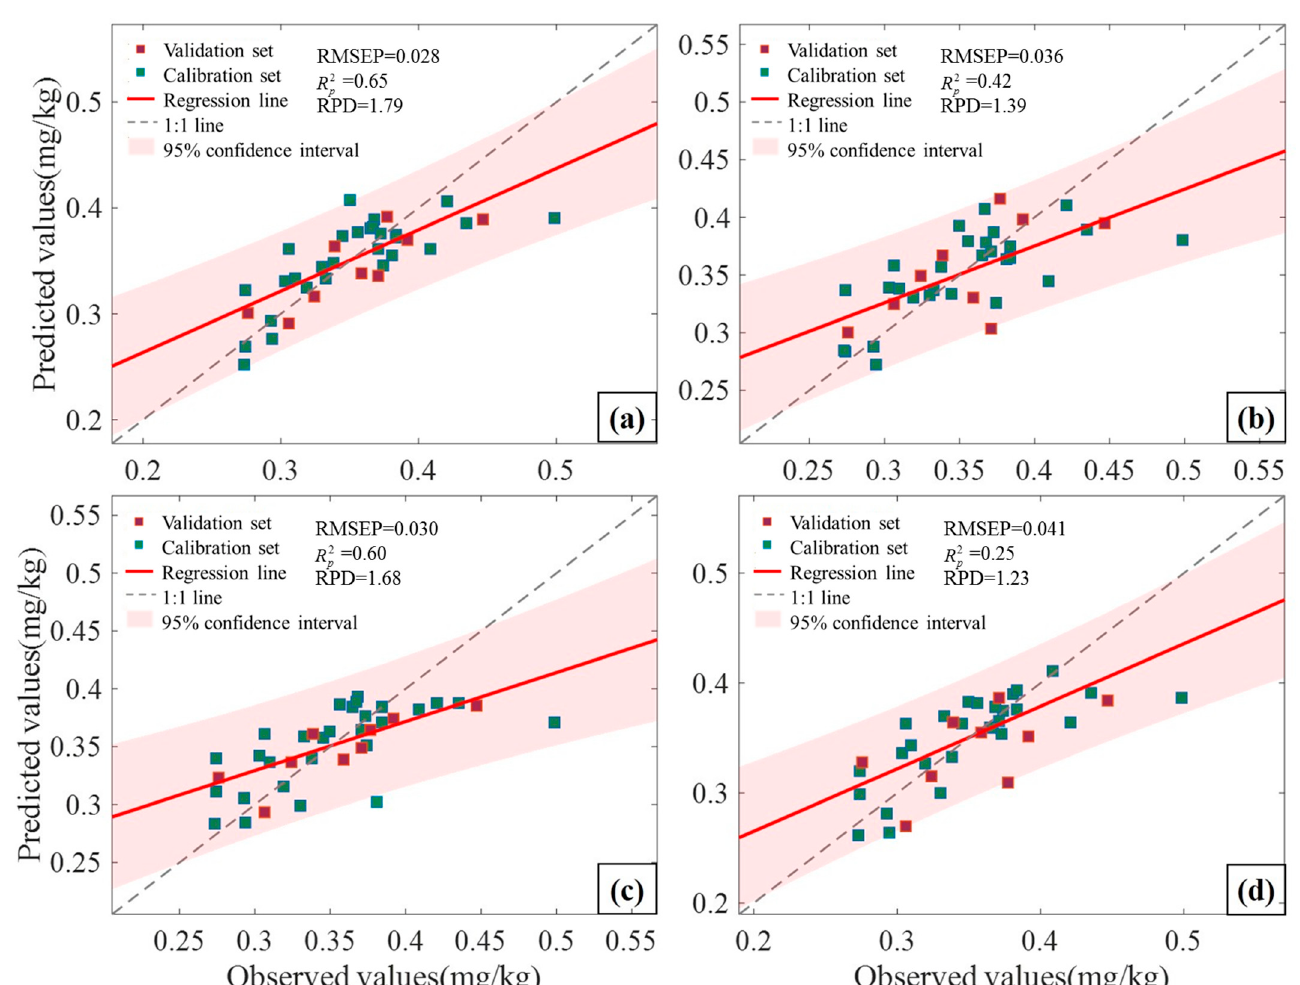
Figure 8. Scatter plots of the observed against predicted Cd concentration of Baoding sample set: ( a ) PLS NSS-VIP-VNIR ; ( b ) CARS-PLS NSS-VIP-VNIR ; ( c ) PLS VNIR ; and ( d ) CARS-PLS VNIR (validation ratio = 1/4).